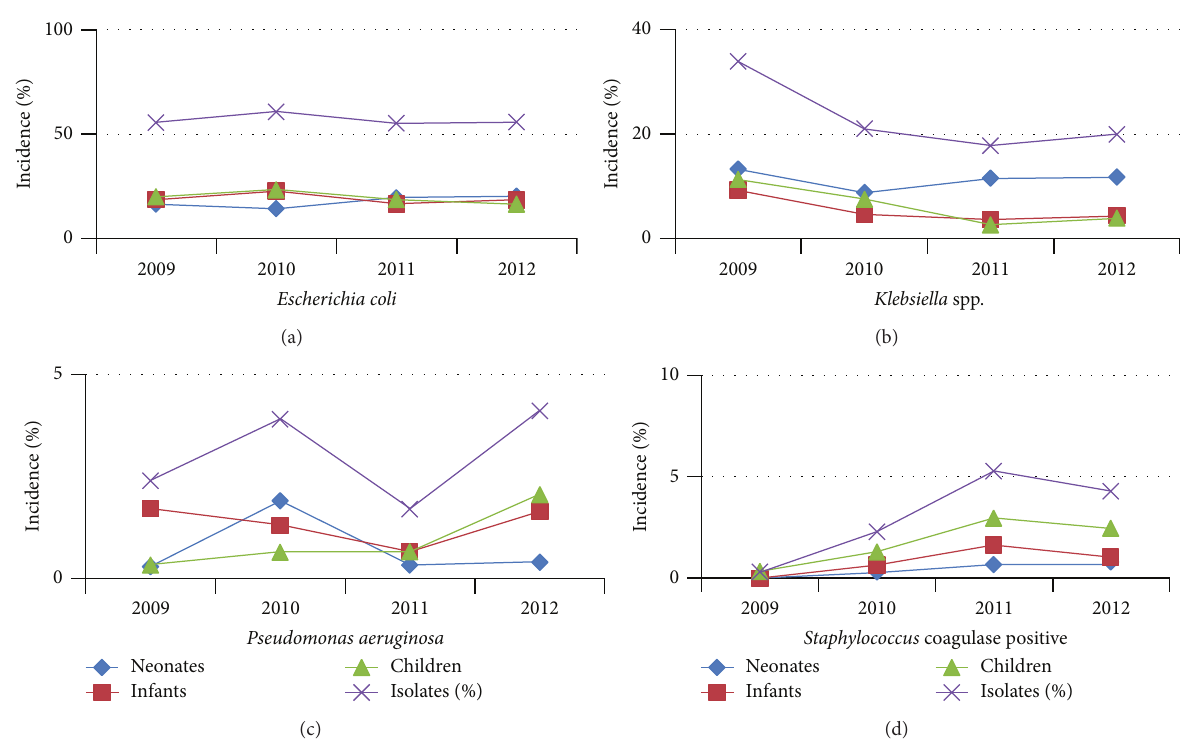
Figure 1: Incidence of the main bacteria implicated in UTI by age during the study